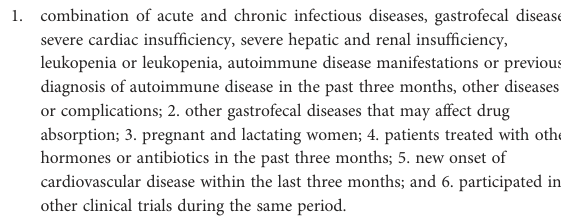
TABLE 1 Inclusion and Exclusion criteria for